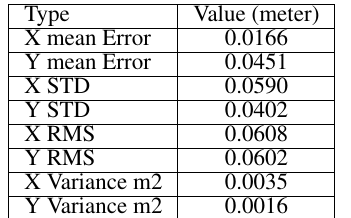
Figure 7. Results of two different estimators in the algorithm isometric view